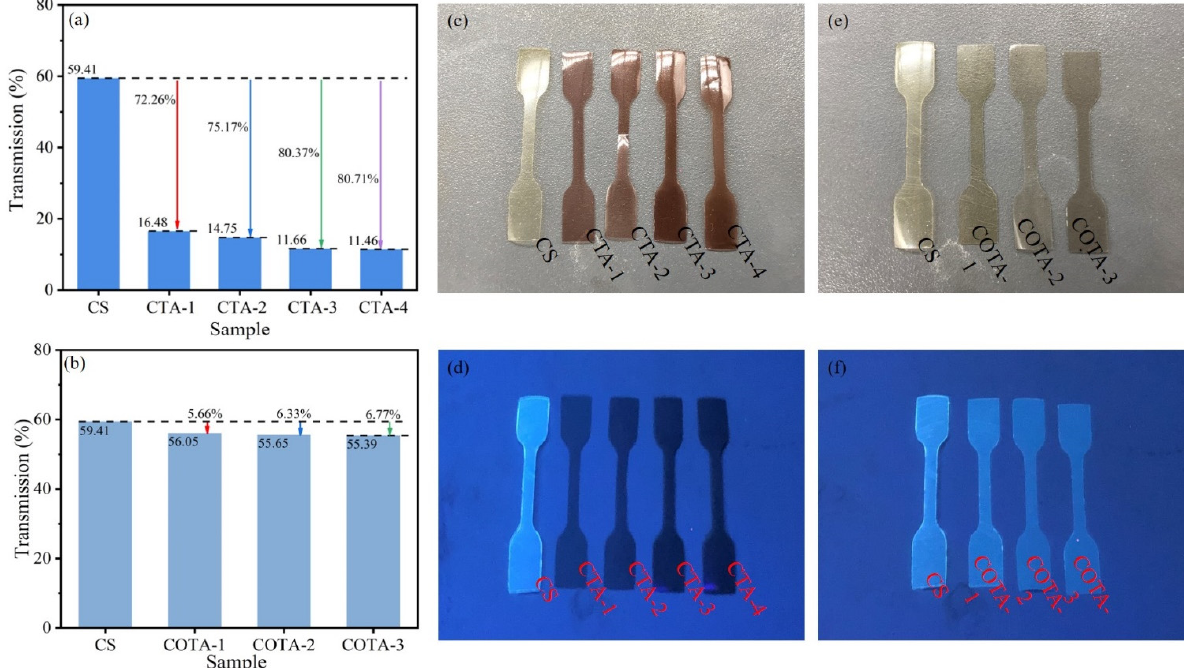
Figure 7. ( a ) The transmittance of CS and CTA solutions under 365 nm UV wavelength; ( b ) the transmittance of CS and COTA solutions under 365 nm UV wavelength; ( c , e ) images of CS, CTA, and COTA films under visible light; ( d , f ) fluorescence images of CS, CTA, and COTA films under 365 nm UV excitation.